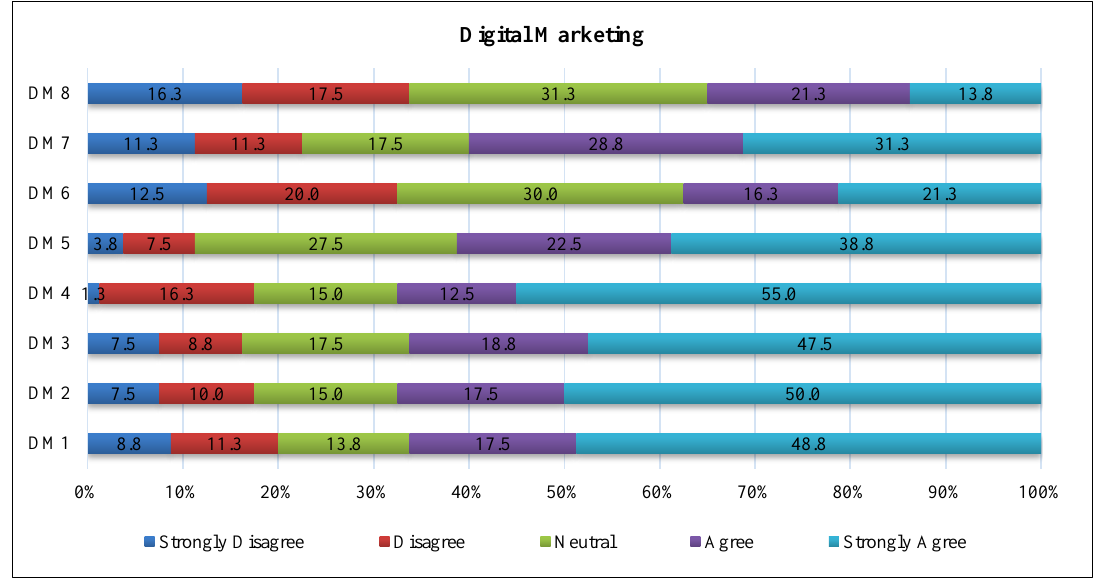
Figure 3. Level of agreement for Digital